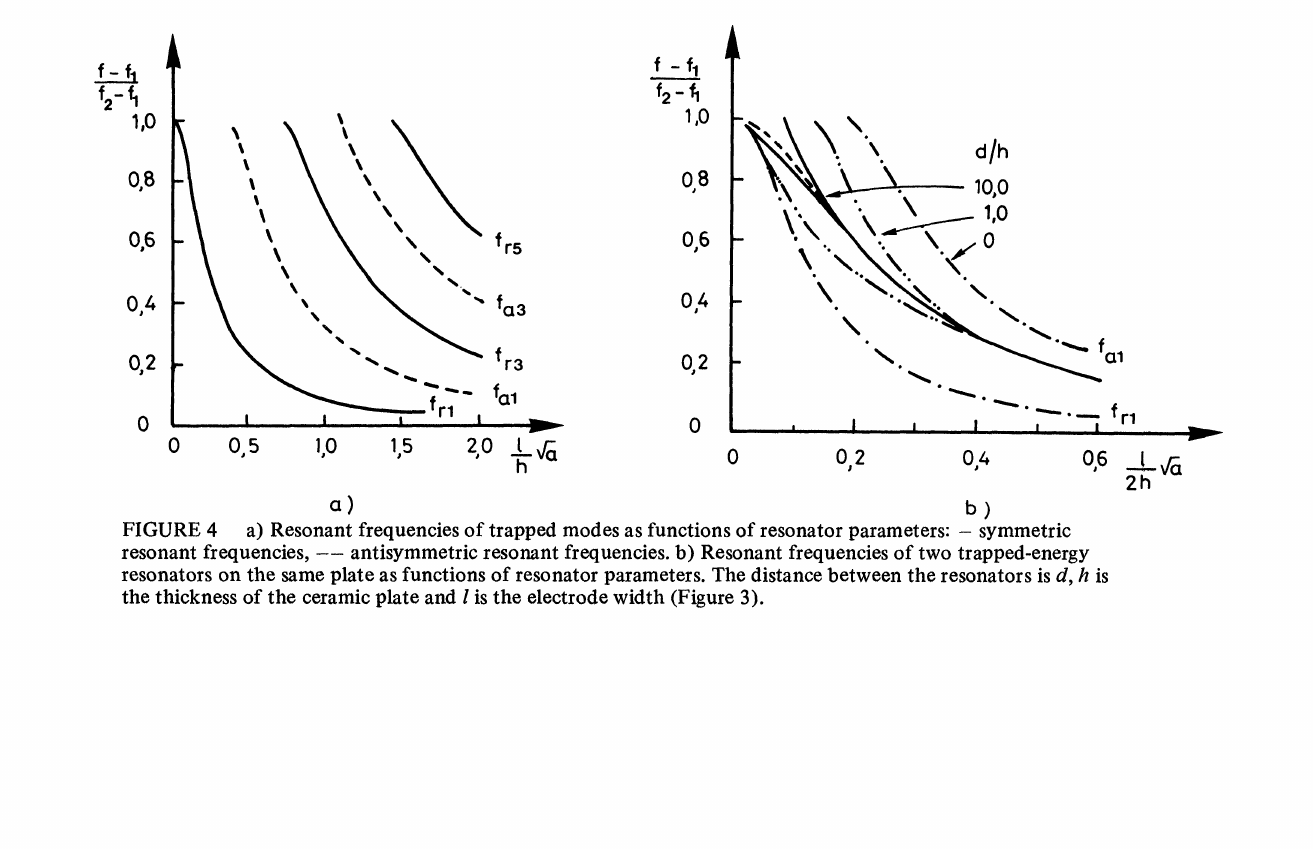
The dimensions of the filter.